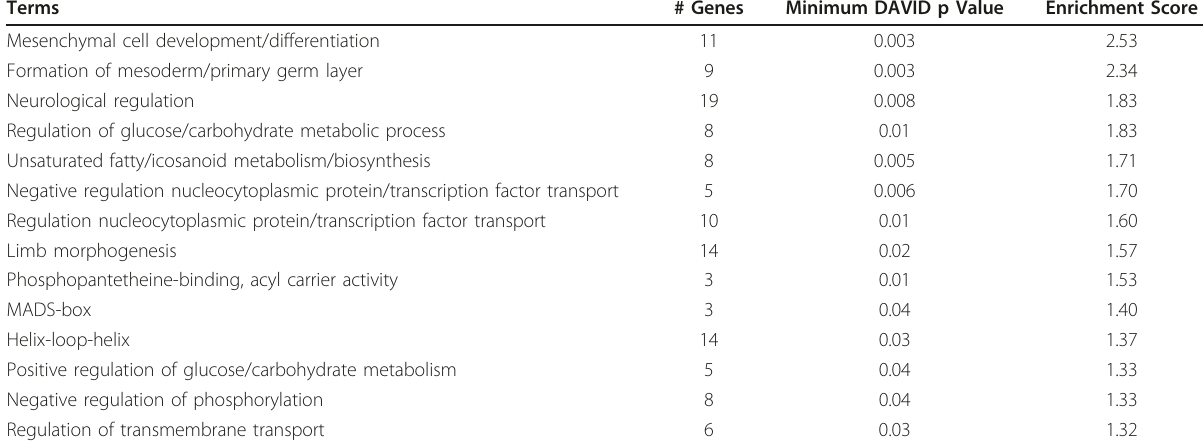
Table 2 Functional clusters of 1,493 CpGs (1,423 genes) with strongest correlations between levels of methylation and maternal age according to